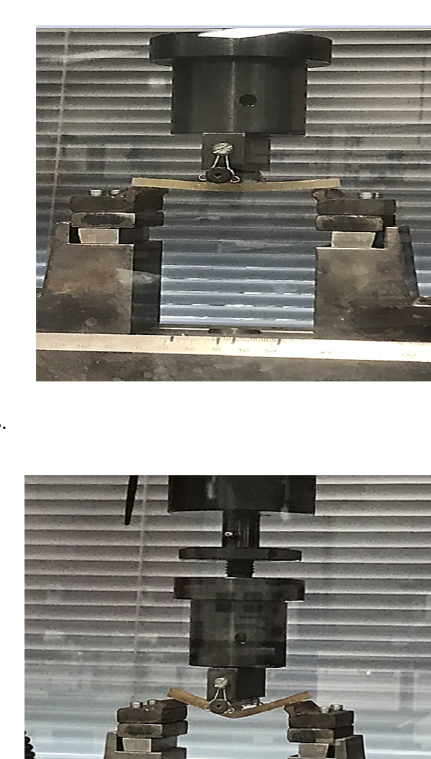
12 of 24 Figure 9. Photograph of the flexural test by using the Instron© 5566. The machine applies the force onto the center of the specimen as shown in Figures 9 and 10 and the resultant applied force in the sample is estimated by the machine which is then presented in terms of flexural stress, flexural strain, and flexural modulus. The flex- ural testing was carried out with a deformation rate of 2 mm/min at a distance of 15 mm from both ends. The maximum flexural stress, flexural strain, and flexural modulus at the midpoint of the samples were calculated by using the following equations: σ f = 3PL/2bd 2 (1) ε f = 6Dd/L 2 (2) E f = mL 3 /4bd 3 (3) where, σ f = Flexural stress (MPa) ε f = Flexural strain (mm/mm) E f = flextural modulus of elasticity P = maximum load at a given point (N) L = distance b/w supports (mm) b = width of tested beam (mm)